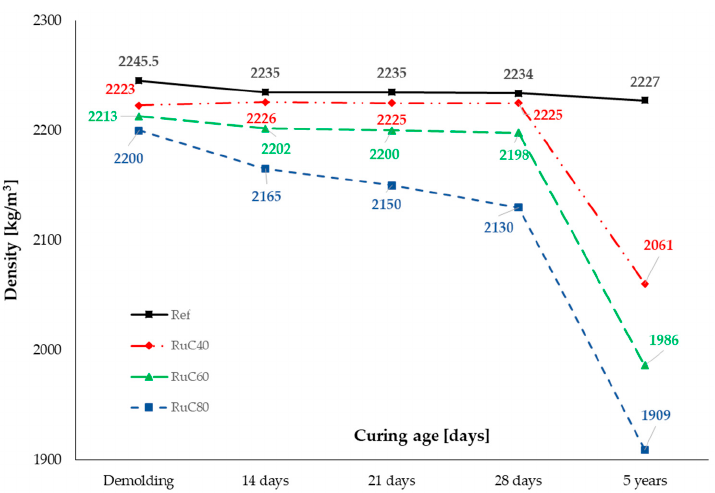
Figure 5. Variation in density with age of specimens.